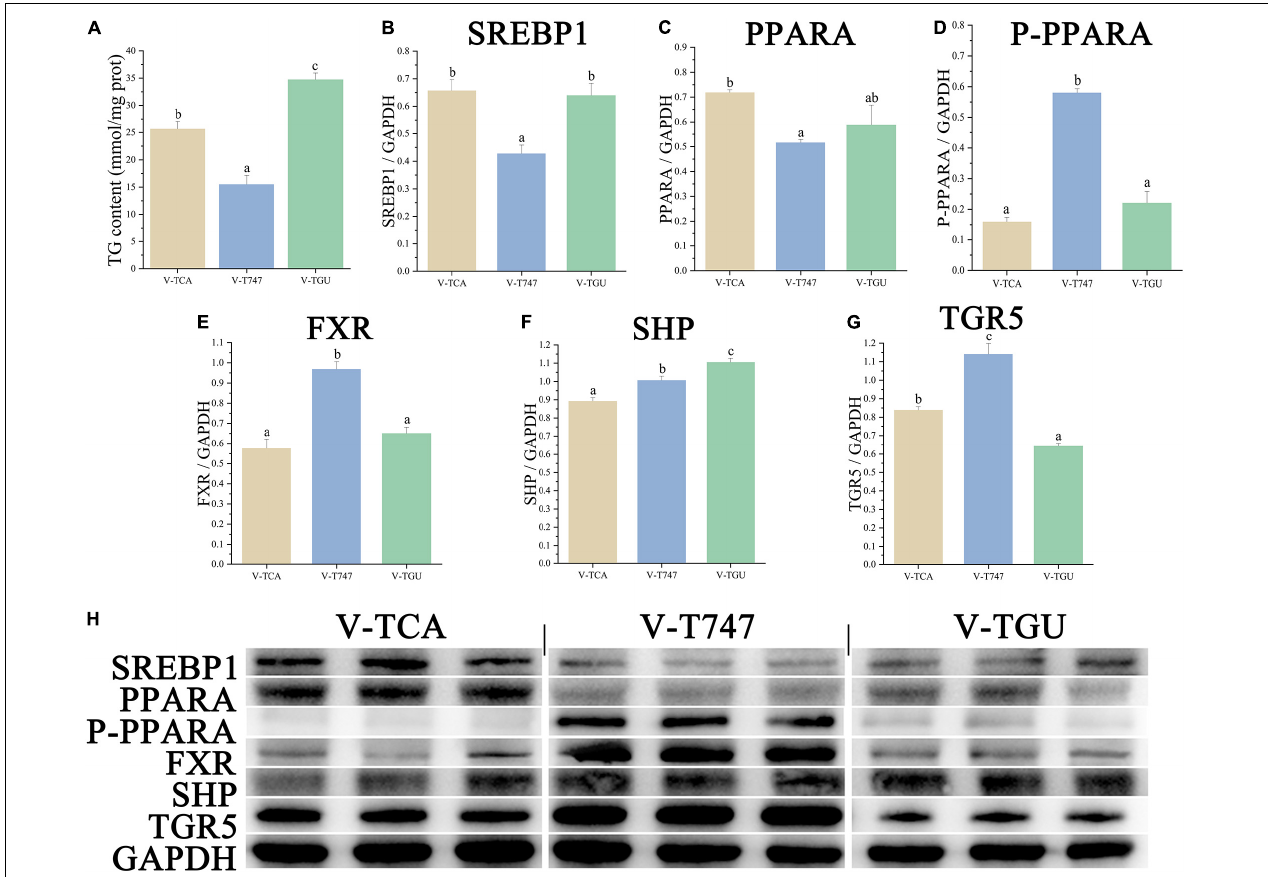
FIGURE 5 | The lipid accumulation and metabolism of hepatocytes in FXR agonist or antagonist incubation. (A) The content of intracellular TG ( n = 9). (B–G) The relative quantification of protein levels normalized to GAPDH in hepatocytes ( n = 3). (H) the Western blot band of hepatocyte samples ( n = 3). Values are presented as means with SD , where significant ( p < 0.05) differences between groups are indicated by different letters.